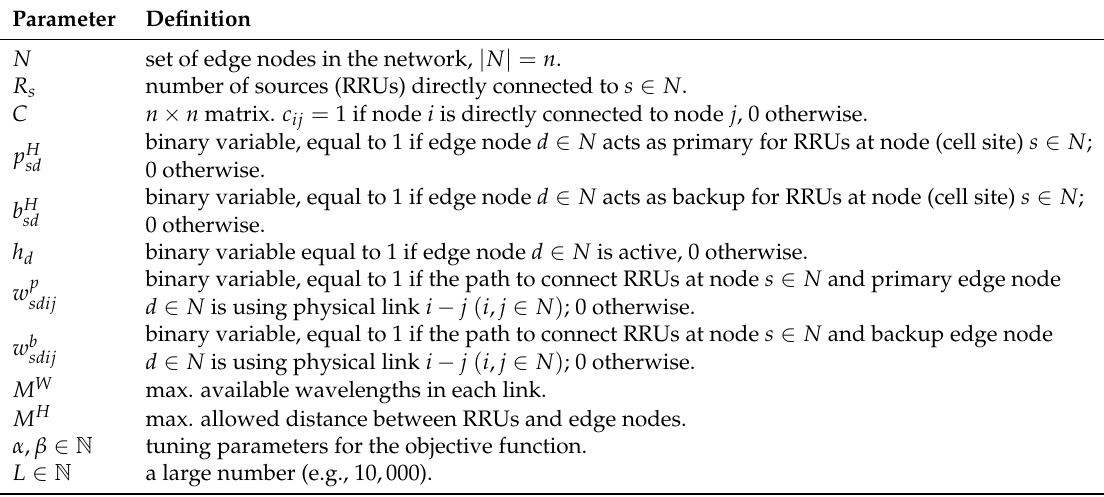
Table 1. Notation for Integer Linear Program